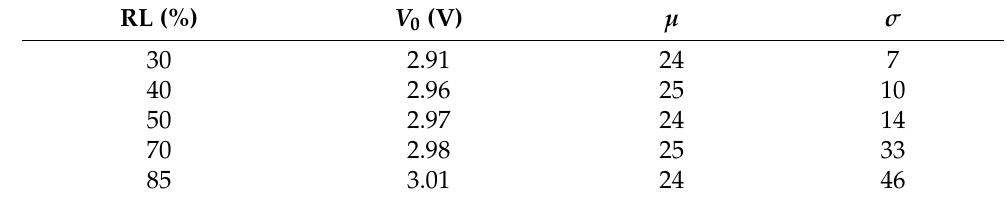
Table 5. Comparison of the output voltages mean and variance of the on-time for simple buck converters for different randomness levels of RCFMFD switching modulation